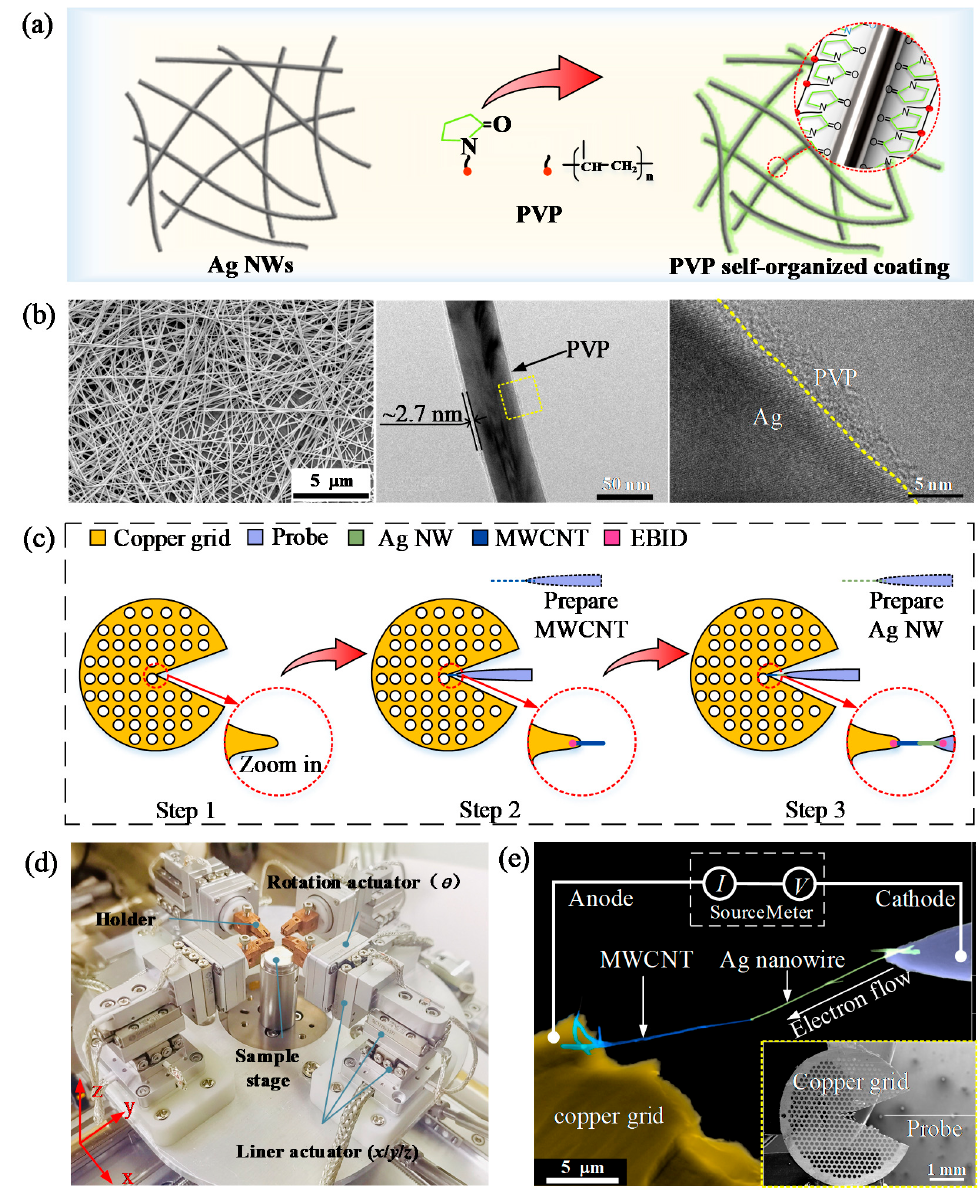
Figure 1. Characterization of PVP-coated Ag NWs and assembly of the MWCNT–Ag NW nanostructure for nanointerconnection. ( a ) Schematic illustration of the self-organized coating of PVP on Ag NWs; ( b ) SEM image ( left ), TEM image ( middle ), and high-resolution TEM (HRTEM) ( right ) image of the PVP-coated Ag NWs; ( c ) Schematic illustration of the MWCNT–Ag NW nanostructure assembly; ( d ) Nanorobotics system; ( e ) Final constructed MWCNT–Ag NW nanostructure. The copper grid is regarded as the anode while the tungsten probe is the cathode. The stable mechanical contact was verified by shifting the Ag NW a distance (e.g., ~100 nm) perpendicular to its axis. If the MWCNT moves together with the Ag nanowire,